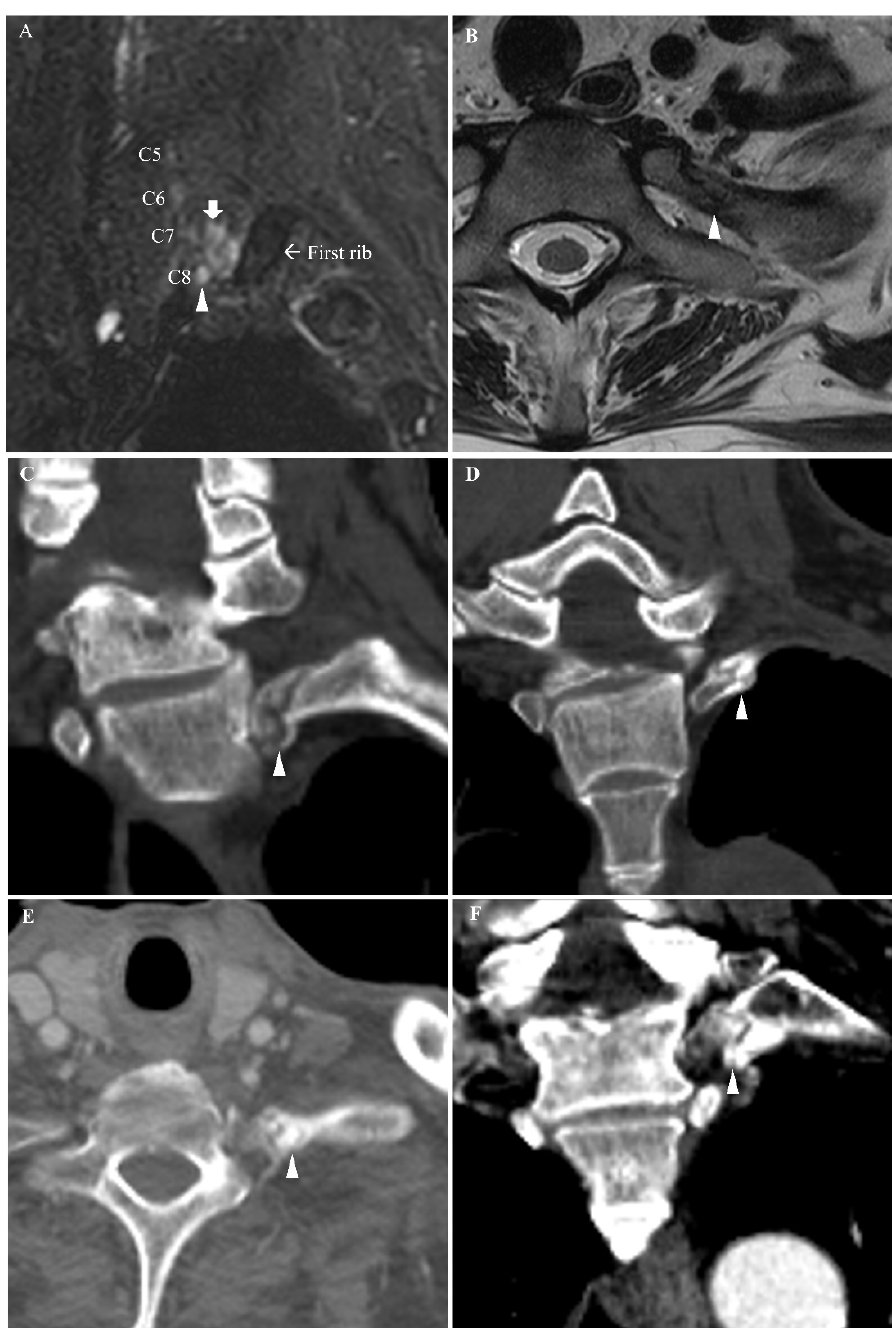
Figure 1. (Case 1: ( A , B )) Brachial plexus and cervical spine MRI findings. ( A ) Parasagittal T2- weighted fat suppression image shows increased T2 signal intensity at left C8 extraforaminal nerve root (arrowhead). T2 Hyperintense area between left C8 root and the left first rib suggests soft tissue edema (short arrow). ( B ) Axial T2-weighted image of the cervical spine shows oblique fracture at the neck of the left first rib between the costovertebral joint and the costotransverse joint without displacement or dislocation (arrowhead). (Case 2: ( C , D )) Coronal chest CT images show ( C ) nondisplaced fractures of the neck of the left first rib (arrowhead) and ( D ) the second rib (arrowhead) without dislocation at the costovertebral and costotransverse joints. (Case 3: ( E , F )) Callus formation was noted at each fracture site. Chest CT images show oblique fracture of the neck of the left first rib and callus formation (arrowhead) in ( E ) axial image and ( F ) coronal image.